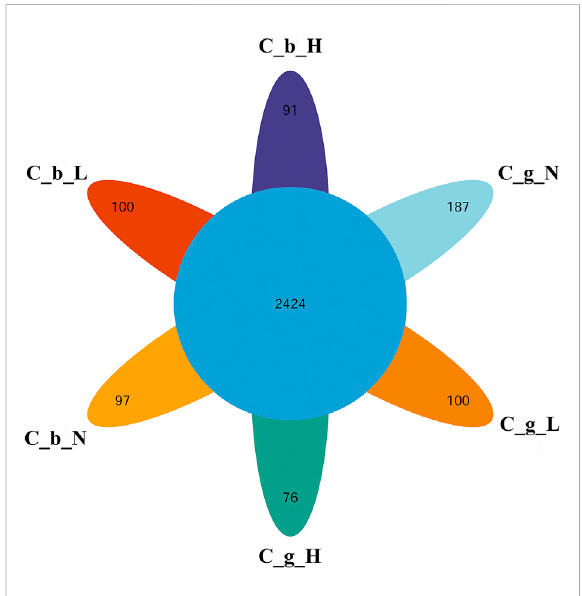
FIGURE 3 OverlapofDIAdataamongdifferenttissuesandtemperature. Note: C_b_N represents brain tissues at 22 ° C, C_b_L represents brain tissues at 4 ° C, C_b_H represents brain tissues at 30 ° C; C_g_N represents gill tissues at 22 ° C, C_g_L represents gill tissuesat4 ° C,C_g_Hrepresentsgilltissuesat30 ° C.Thenumberin the center represents the number of common proteins. The number in each petal represents the number of unique